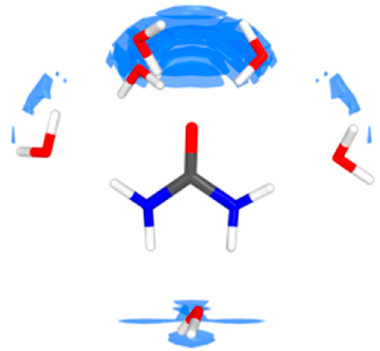
Figure 5. Comparison of the water placements around urea obtained with the FEBISS algorithm and the 3D reference interaction site model (3D-RISM) approach. The urea–(H 2 O) 6 complex is represented with sticks, while the water densities obtained with the 3D-RISM approach are shaded in blue.